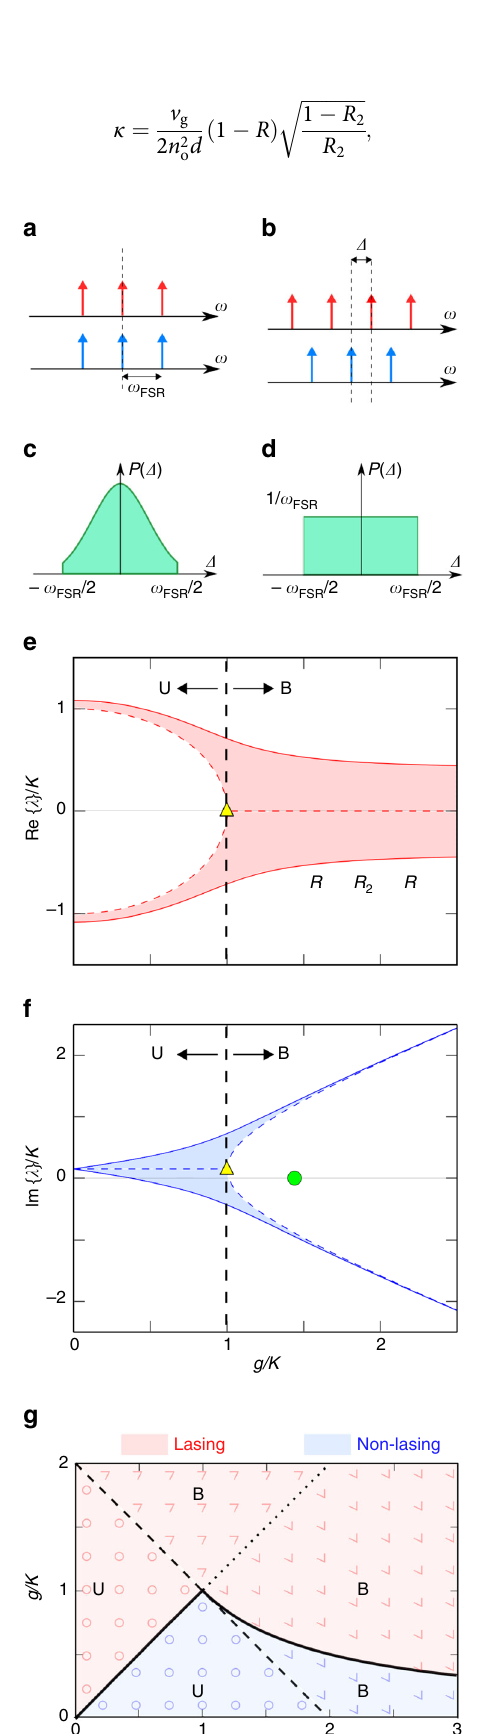
ffiffiffiffiffiffiffiffiffiffiffiffiffi